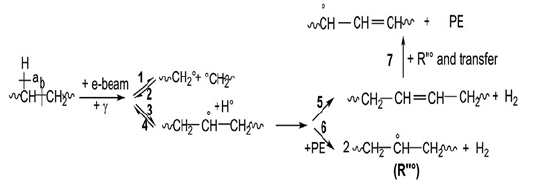
(E = 40.4 Figure 5. Initiation reaction by high energy radiation on polyethylene. 2 a Adapted from Bracco el at 47